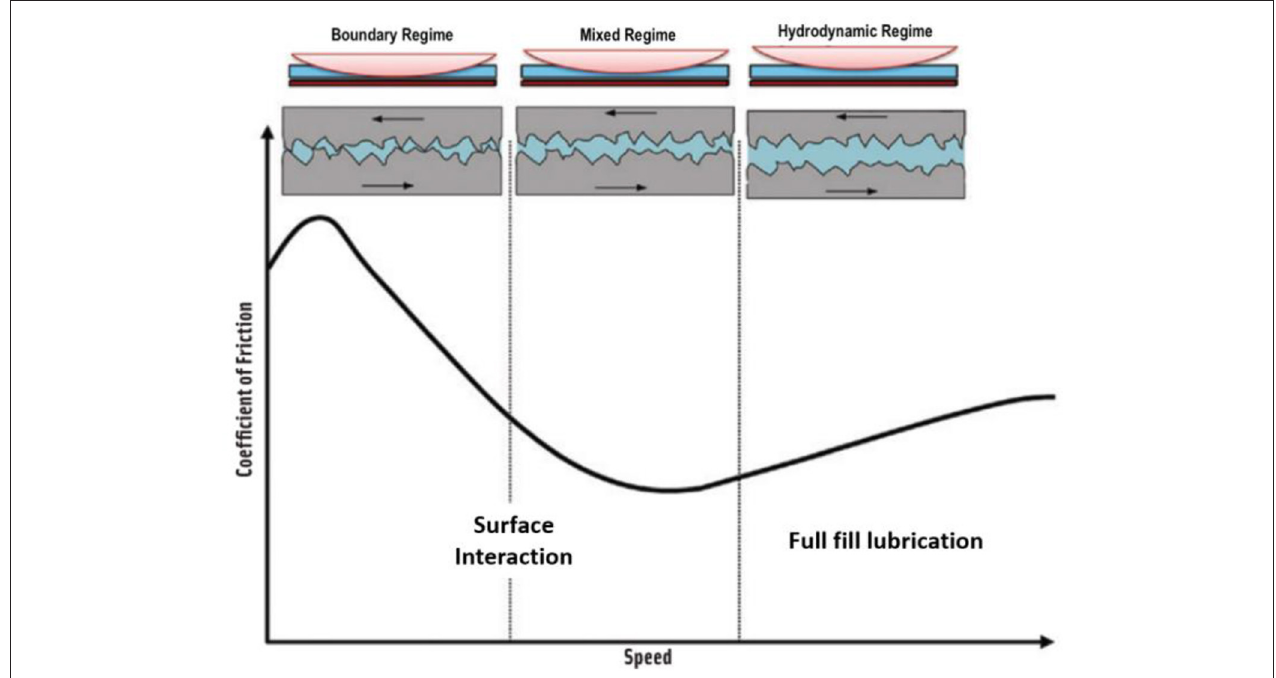
FIGURE 1 | Typical stribeck curve with the three different lubrication regimes. From: Mermelstein (22).